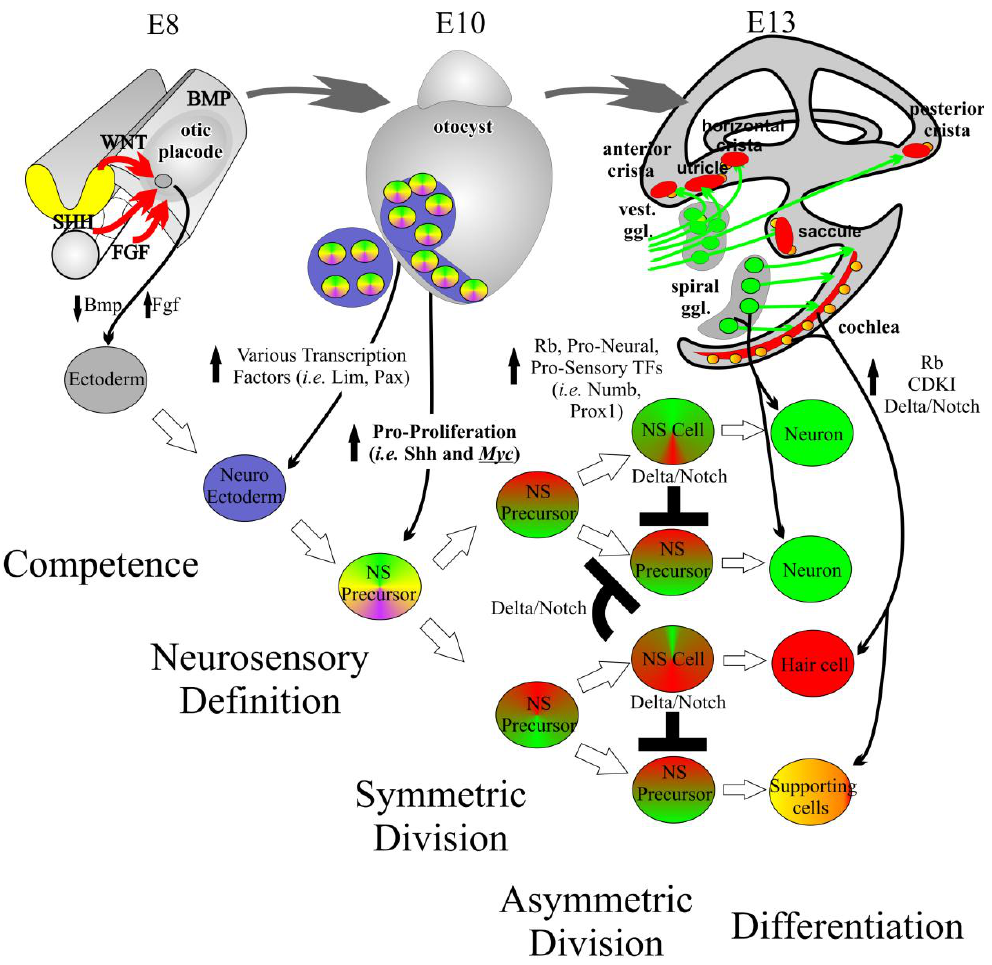
Figure 3. Inner ear development requires controlled proliferation. The inner ear begins as an undifferentiated patch of ectoderm adjacent to the hindbrain at embryonic day (E) 8. Through induction by diffusible factors such as the Wnts and Fgfs, neuroectoderm is formed. From this neuroectoderm, neurosensory (NS) precursor cells are formed. NS precursors have the ability to form neurons, hair cells, and supporting cells. An initially small population of NS precursor cells undergoes symmetric division leading to additional NS precursor cells. This multiplication is in part driven by proto-oncogenes such as the Mycs . At a certain point, tumor suppressor genes, pro-sensory genes, and pro-neural genes increase leading to the asymmetric division of NS precursor cells into differentiated NS cells. The formation of NS cells such as neurons and hair cells help maintain the differentiated state of nearby supporting cells. The differentiated state is further maintained by high levels of cyclin dependent kinase inhibitors (CDKIs) and retinoblastoma (Rb). Modified from